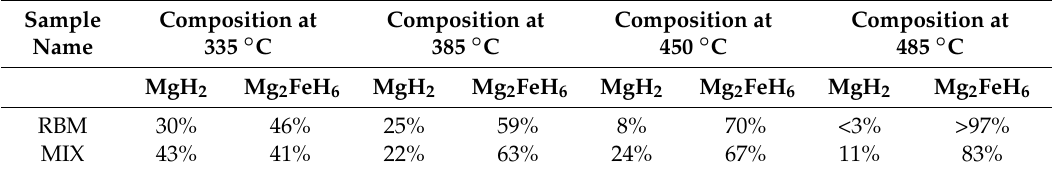
Table 1. Composition of samples (at %) cycled at various temperatures, calculated from the pressure composition isotherms reported in Figure